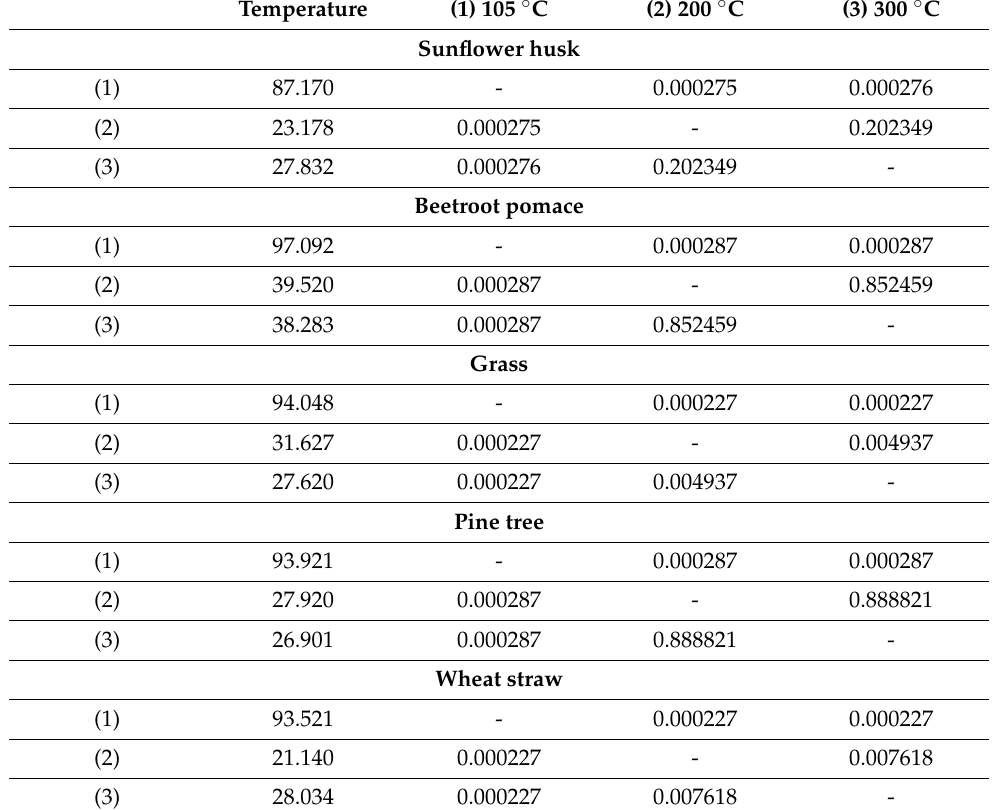
Table 3. Statistical results of the ANOVA and post hoc Tukey test of the influence of torrefaction temperature on the mechanical durability for an operation time of 60